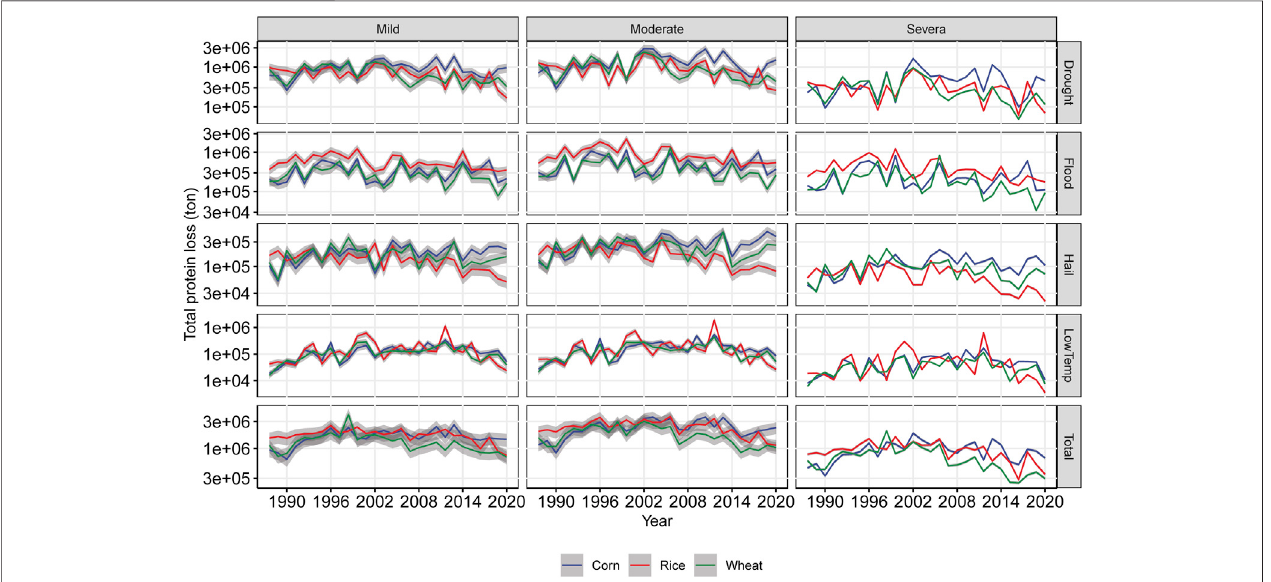
FIGURE10 | Trends in protein loss from agricultural production in maize, rice, and wheatdue to different natural disasters from 1988 to2020. The shaded regions represent one standard deviation of the protein loss in China ’ s agriculture.